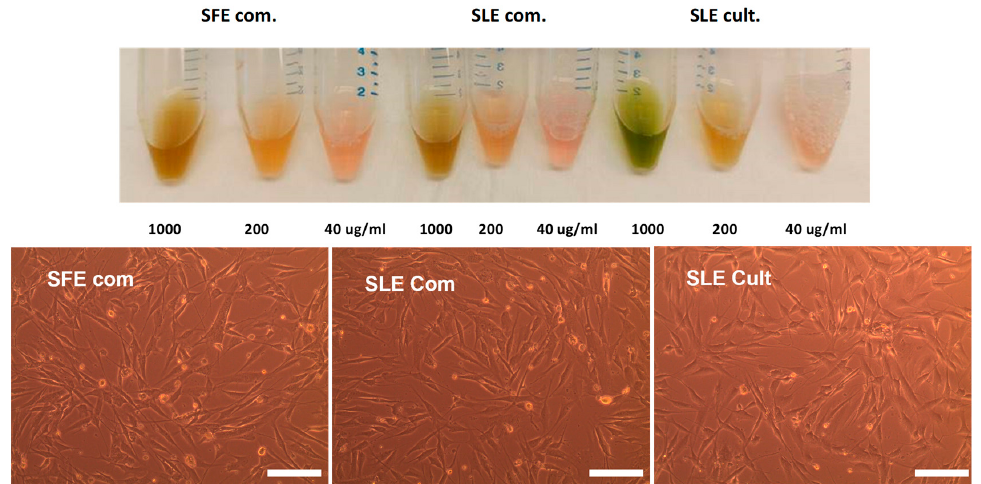
Figure 1. Solubility of C. vulgaris extracts obtained by different extraction methods. Upper panel: Representative pictures of serial dilutions of C. vulgaris extracts in DMEM/F12 10% FBS medium. Bottom panels : Microscope images of MSCs incubated with extracts SFE com, SLE com, SLE cult, showing that the extracts are well soluble in medium at 50 μ g/mL, as no insoluble aggregates are observed. 10X objective, Leica DM IL. Scale bar, 100 μ m.